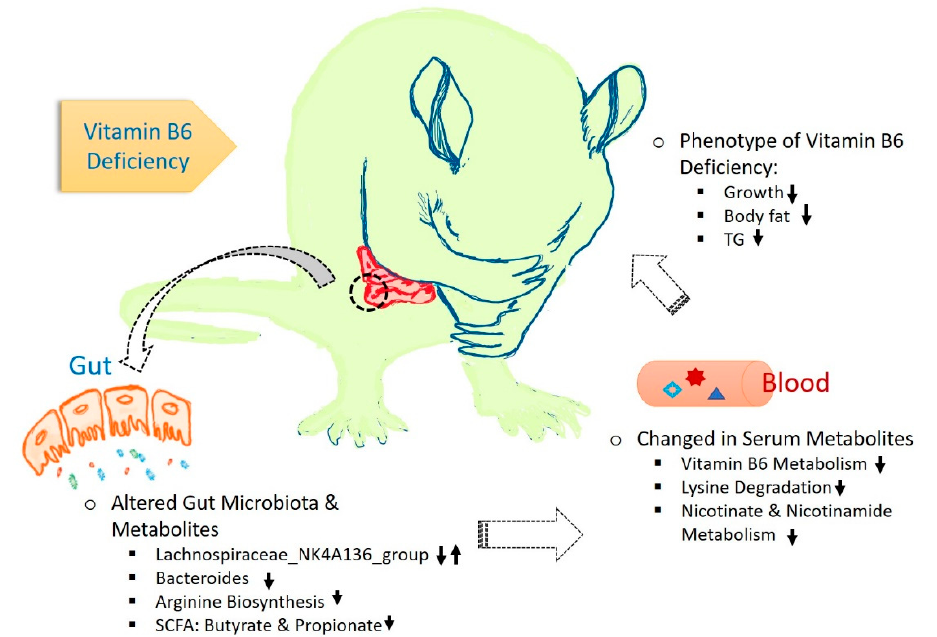
Figure 7. Proposed model showing the interrelationship between the gut microbiota, microbial metabolites and the host metabolism in vitamin B6 deficiency. Up arrows indicate upregulation, down arrows indicate downregulation and double arrows indicate mixed regulation.